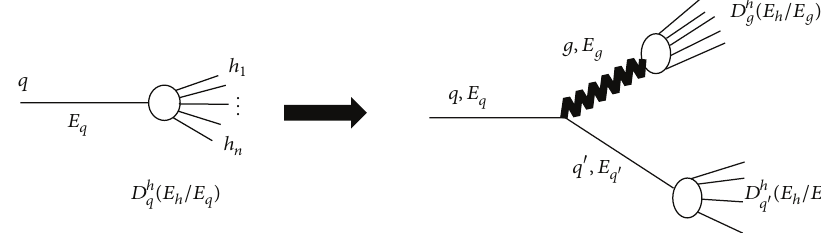
Figure 9: An overview of how a gluon radiation leads into scaling